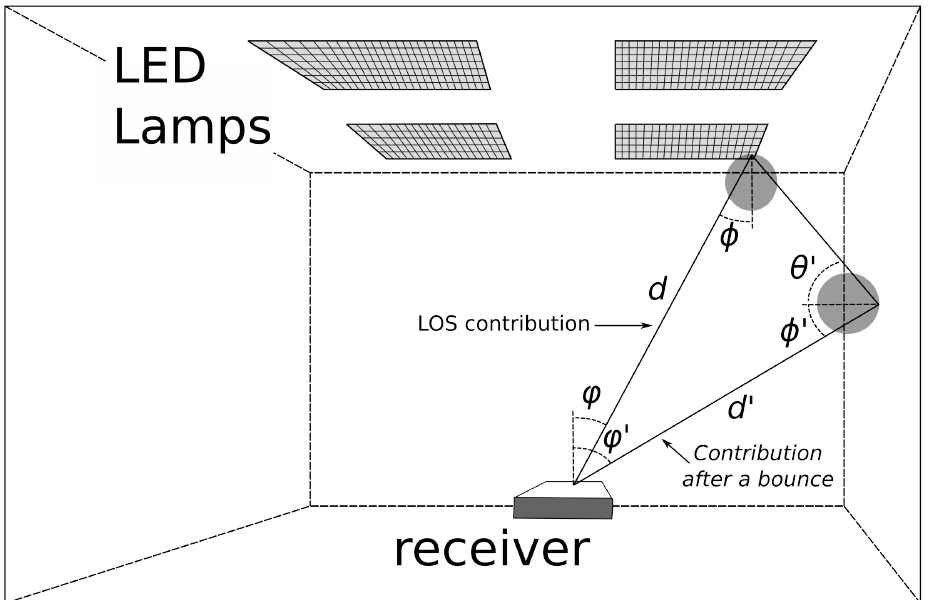
Figure 1. Illustration of the indoor VLC environment with LOS contribution of a single LED and its power contribution after off a